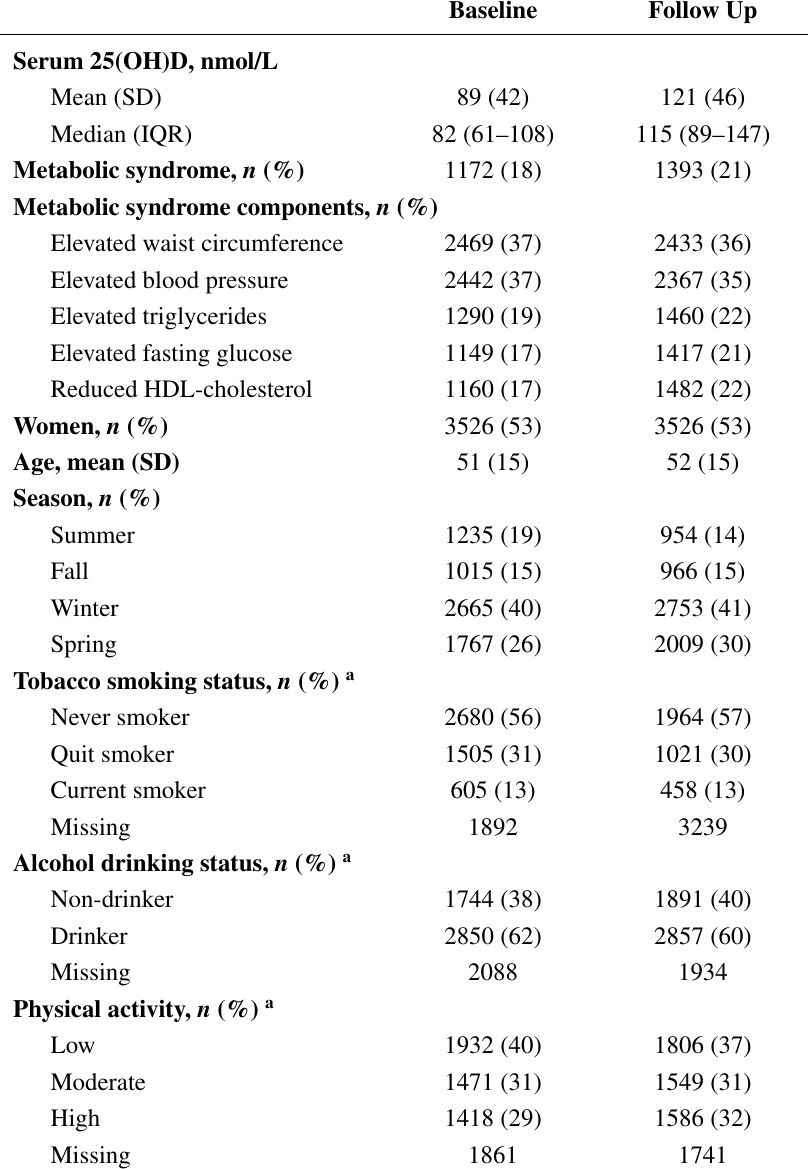
Table 1. Baseline and follow up characteristics of 6682 study participants.